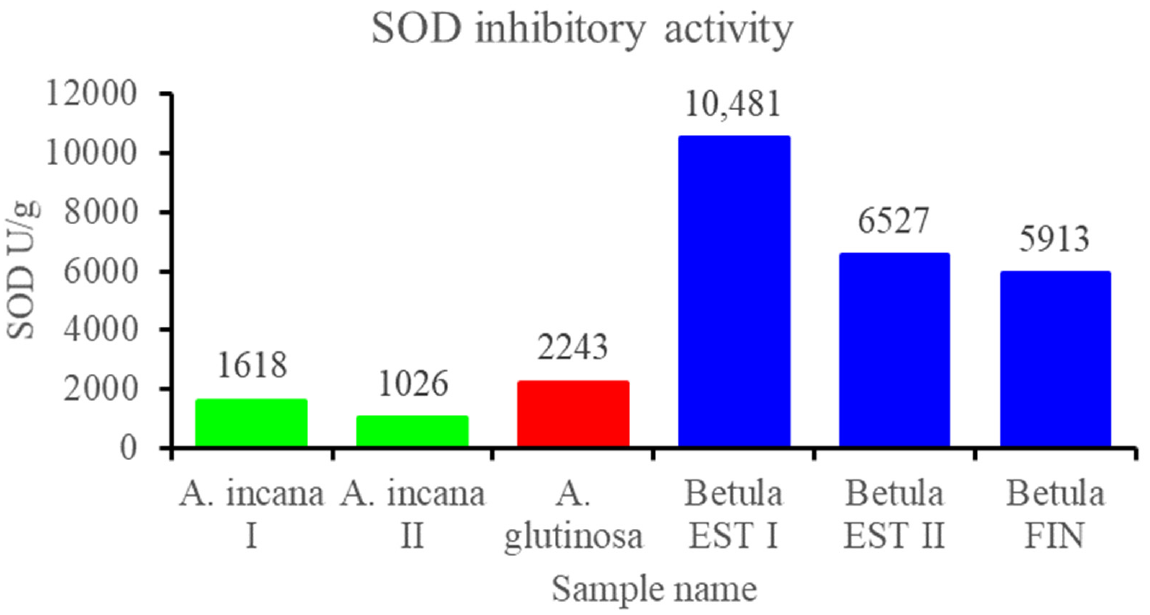
Figure 2. SOD inhibitory activity of 80% ethanol extracts from the conks expressed as SOD units per g of dry material (SOD U/g). One unit of SOD activity was defined as the amount of enzyme having a 50% inhibitory effect on WST-1.